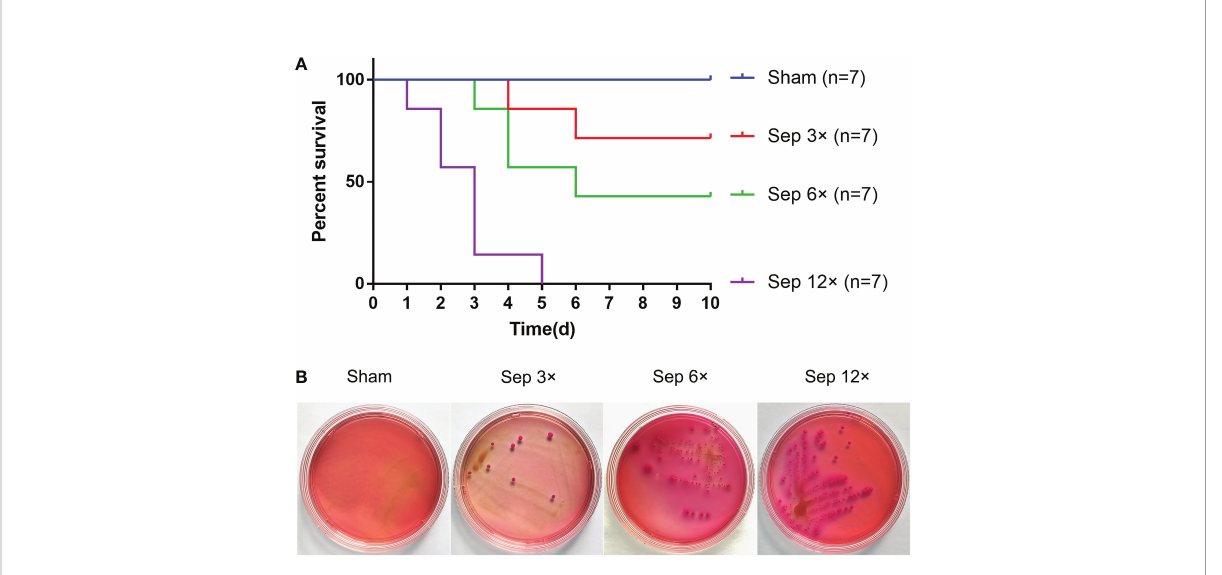
FIGURE 2 Survival analysis and Blood cultures after ureter ligation and inoculation of E coli. (A) Survival analysis after ureter ligation and inoculation of E coli . (B) Blood specimens were incubated on MacConkey agar at 37°C after 24h inoculation with E coli .